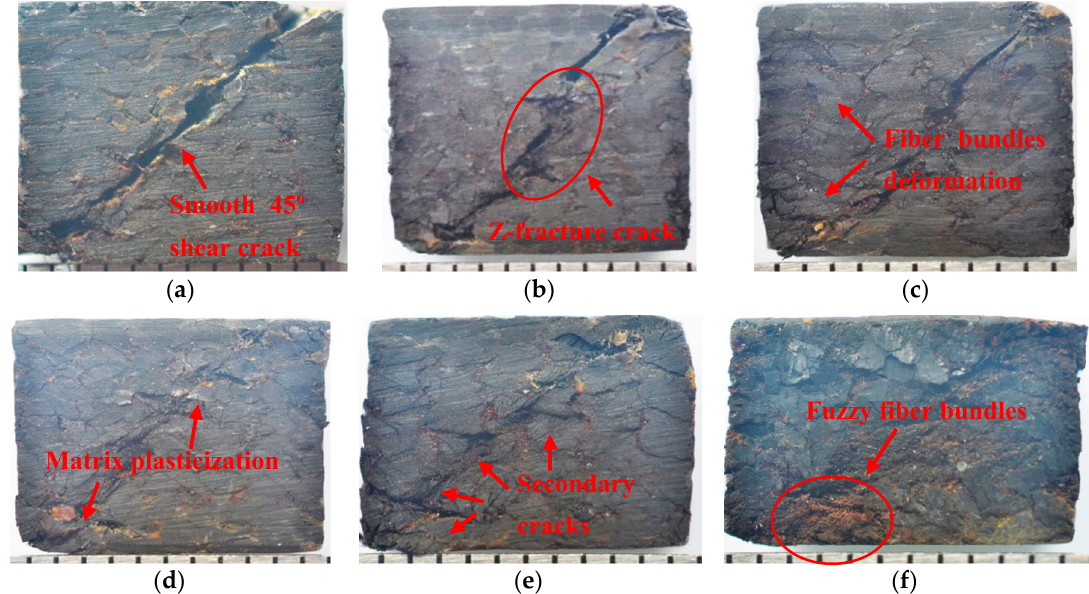
Figure 9. Damage morphologies of specimens with 32° braiding angle at different temperatures: ( a ) 25 °C, ( b ) 60 °C, ( c ) 90 °C, ( d ) 120 °C, ( e ) 150 °C, and ( f ) 180 °C.